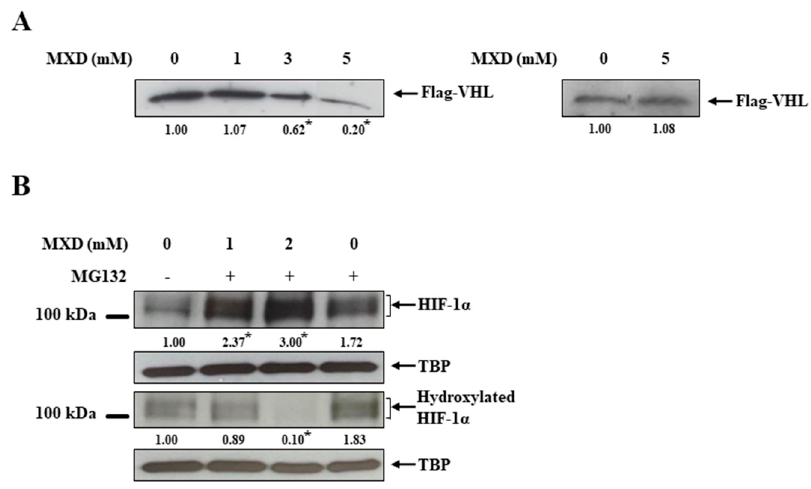
Figure 4. Millimolar minoxidil inhibits HIF prolyl hydroxylase. ( A ) ( Left ) A VHL capture assay was performed in the presence of minoxidil (MXD) at various concentrations, and the resultant blots were probed with the antibody to Flag (VHL). ( Right ) The same assay was repeated utilizing a chemically hydroxylated peptide and MXD (5 mM) ( n = 5), * p < 0.05 versus untreated group; ( B ) HaCaT cells were treated for 4 h with MXD or MG132 (10 μ M), a proteasome inhibitor, and were lysed to obtain nuclear extracts. Blots were probed with an anti-HIF-1 α antibody and an anti-hydroxylated HIF-1 α antibody ( n = 5). * p < 0.05 versus untreated group. Western blot results are representative of five independent experiments. TBP: TATA binding protein.